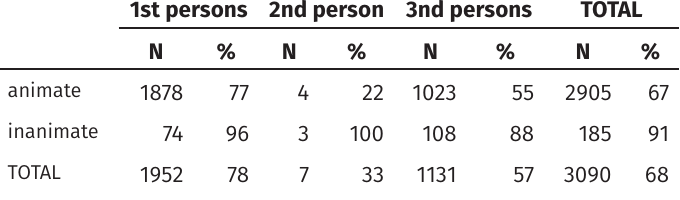
Table 16: Cross tabulation between animacy and person and number for the use of null subject: number of participants and